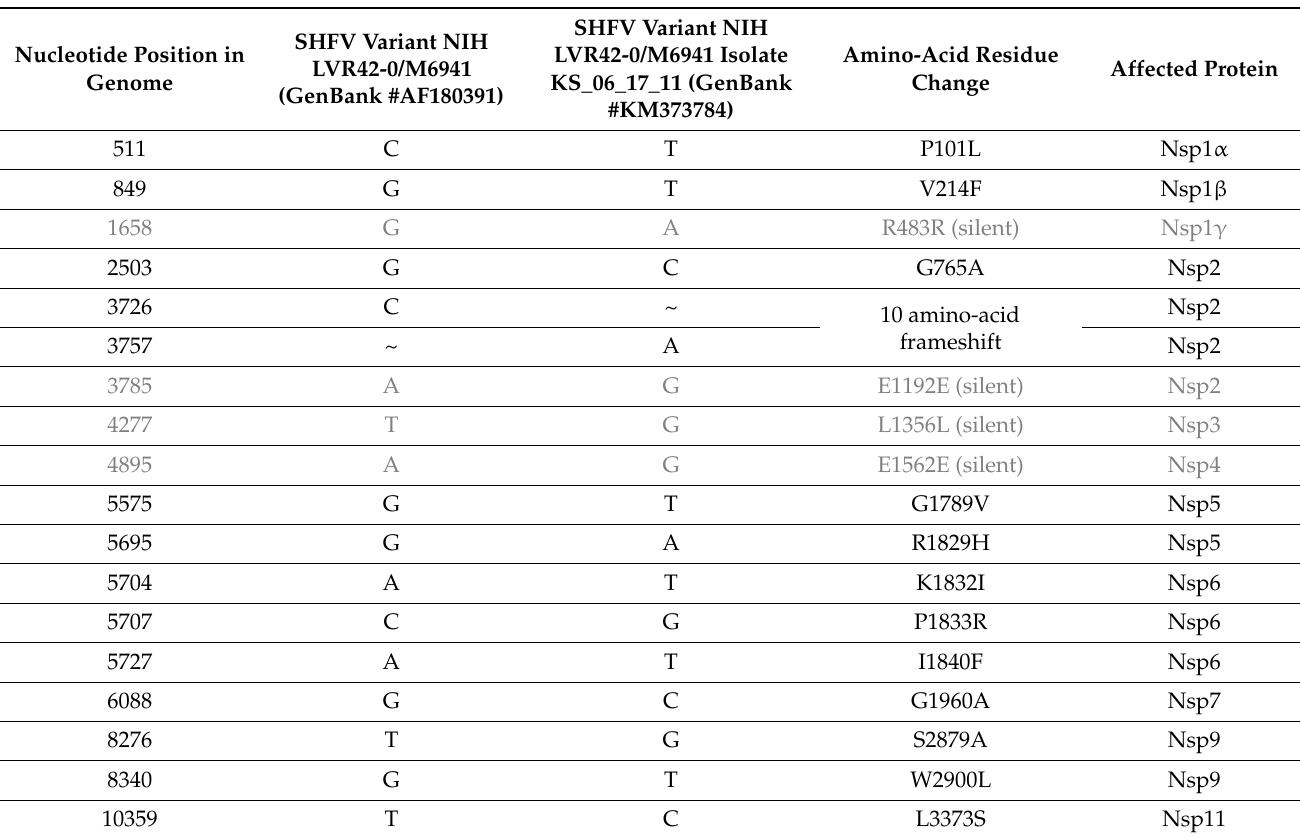
Table 1. Nucleotide differences between simian hemorrhagic fever virus (SHFV) variant NIH LVR42-0/M6941 genomes